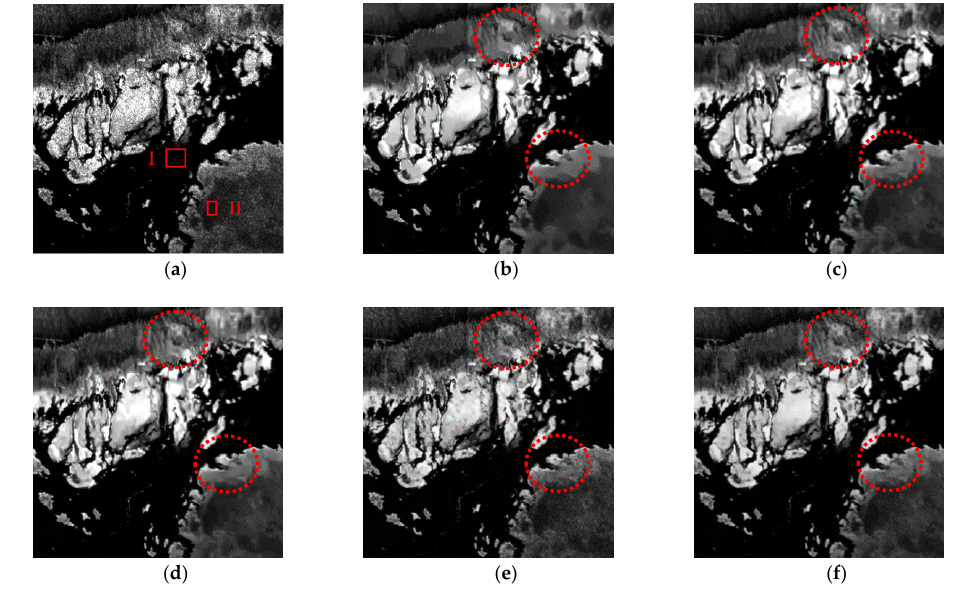
Figure 10. Filtered images for the Deathvalley SAR image contaminated by four-look speckle. ( a ) Original image. ( b ) PPB [13]. ( c ) SAR-BM3D [14]. ( d ) SAR-POTDF [16]. ( e ) SAR-CNN [28]. ( f ) SAR-DRN.